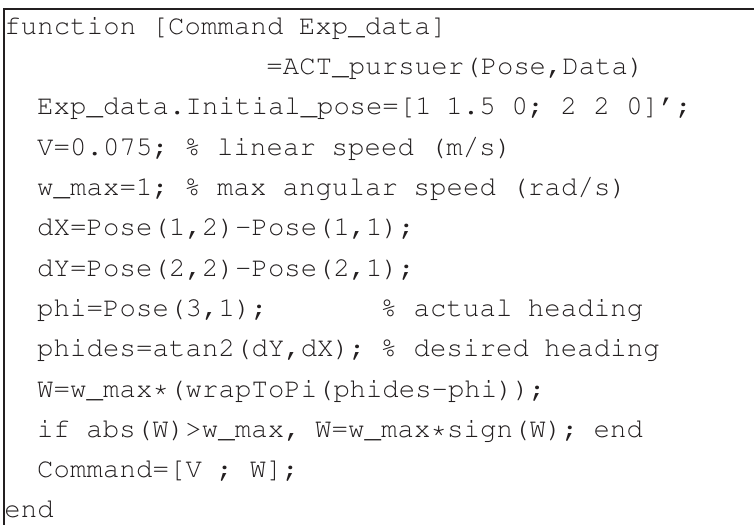
Figure 9. Pursuer-evader games: the Matlab function implementing the pursuer